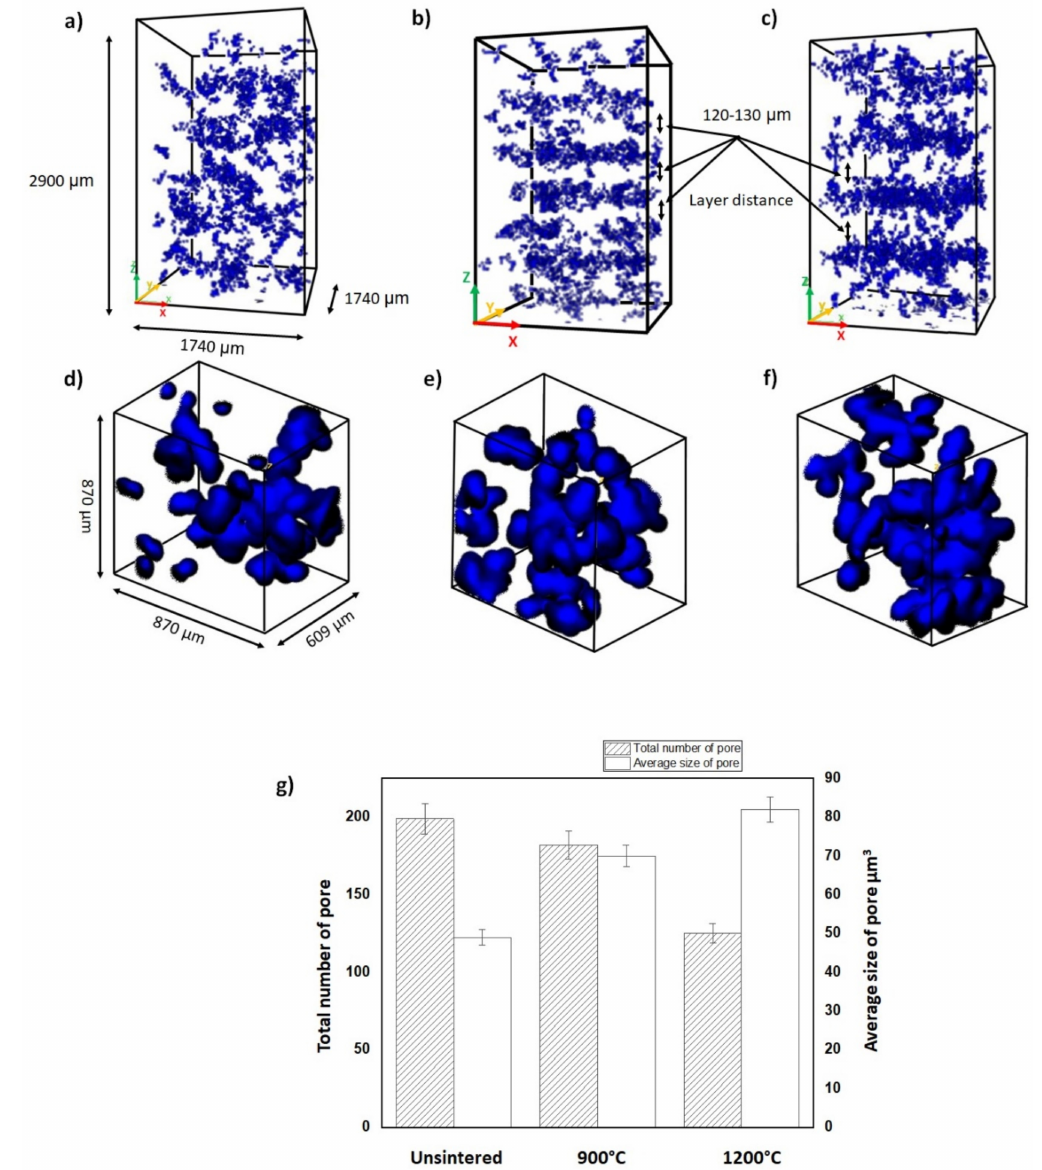
Figure 6. Tomography imaging of ( a ) unsintered and sintered geopolymer at ( b ) 900 and ( c ) 1100 ◦ C. ( d – f ) Tomography imaging with zoom and higher resolution and ( g ) total pore numbers and average pore